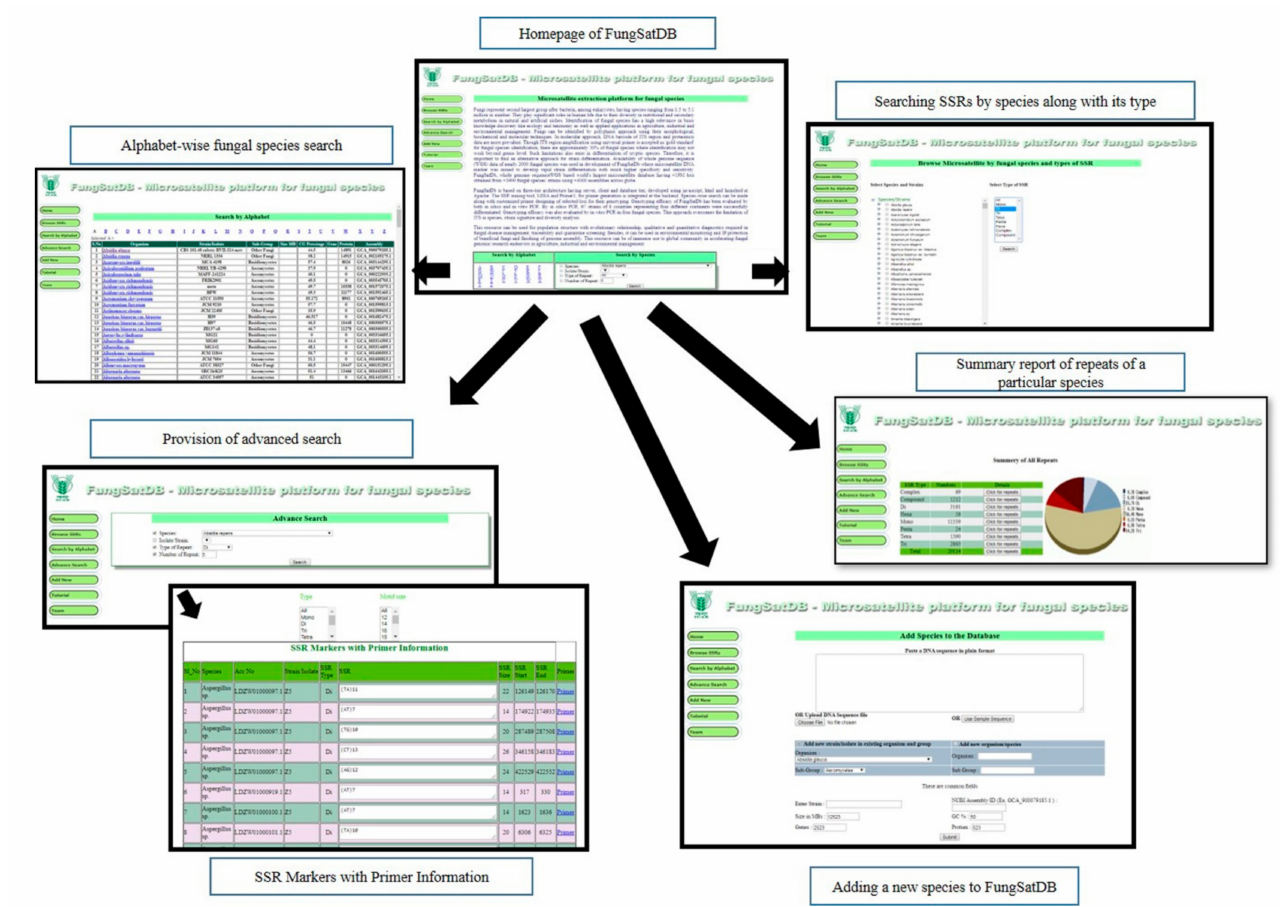
Figure 4. Flow chart of FungSatDB which includes mining pipeline of markers identification, analysis, structure, and